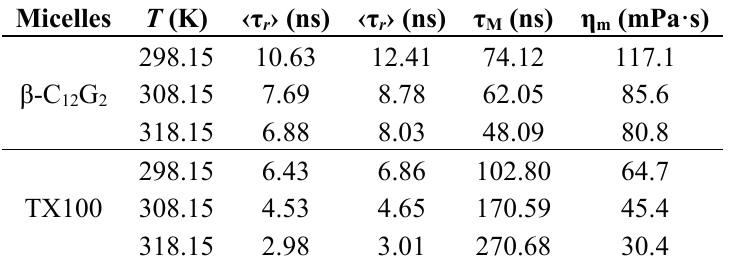
Table 3. The effect of temperature on the micellar microviscosity as determined from the average rotational time of C6 in